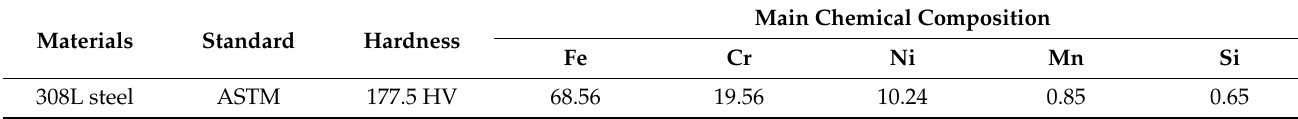
Table 1. Parameters of substrates made from 308L steel.